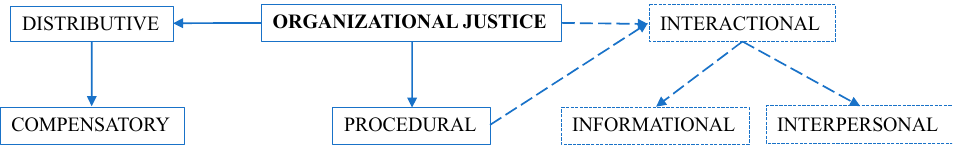
Figure 1. Conceptualization of fairness in literature.